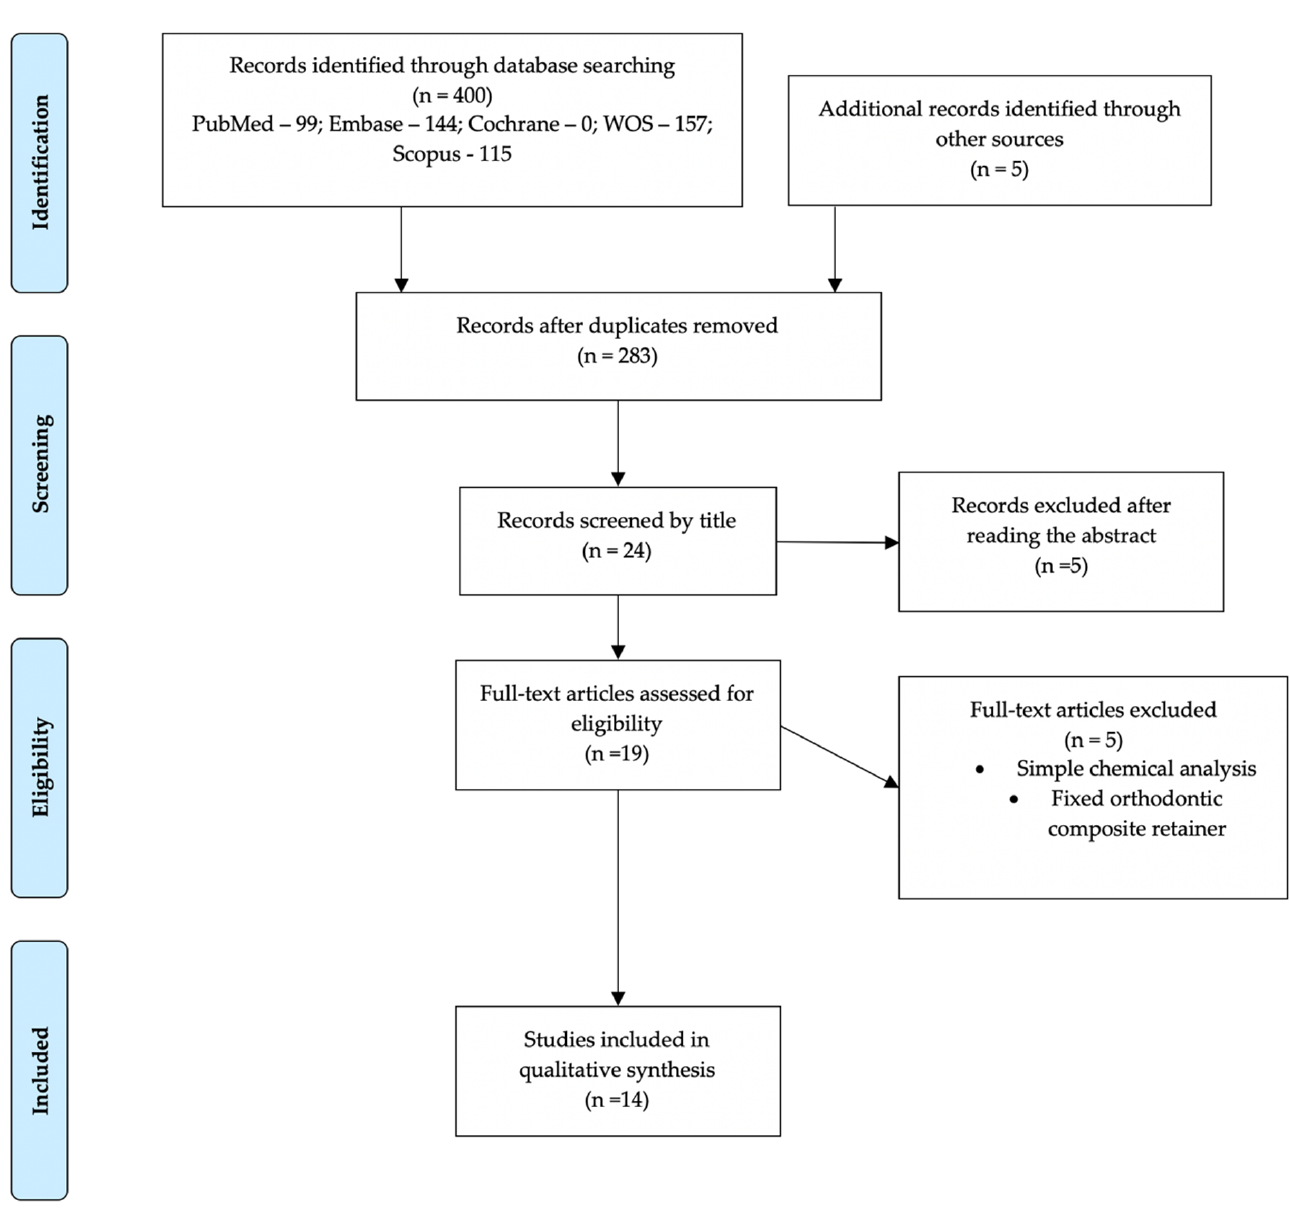
Figure 1. Flow Diagram of the eligibility of publication scrutiny according to PRISMA guidelines.